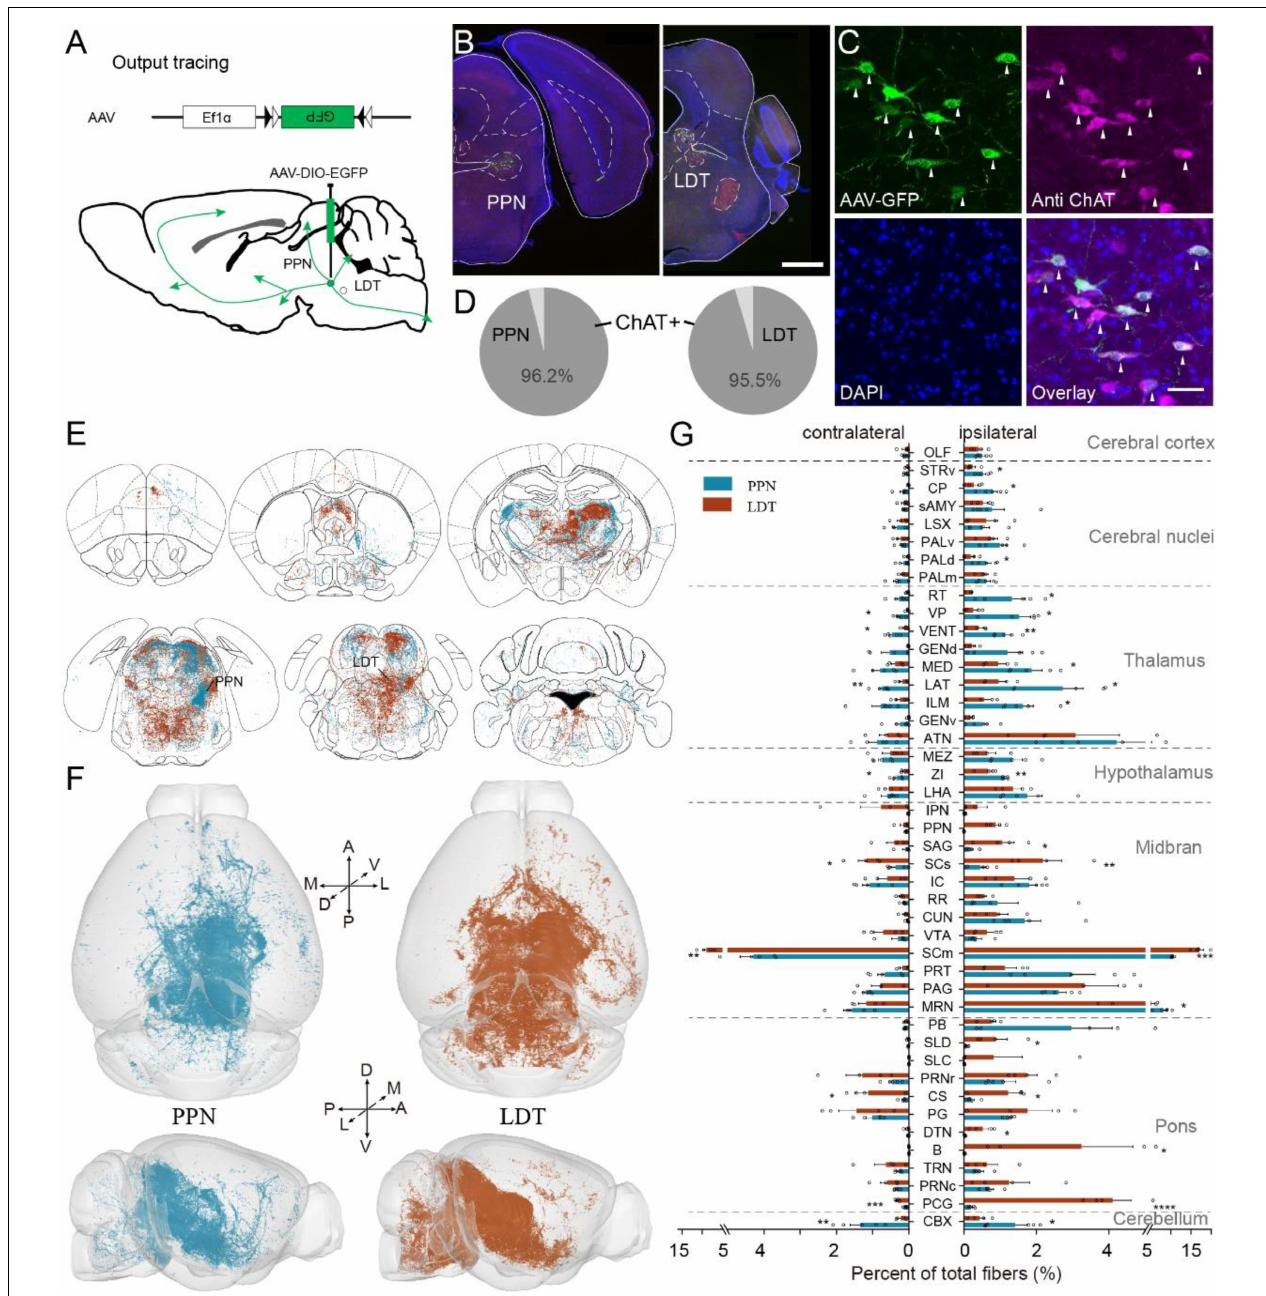
FIGURE 3 | Whole brain projection of PMT cholinergic neurons. (A) The methods and processes for output tracing. (B) A typical coronal plane of an inject site; labeled cholinergic neurons are limited in object regions. (C) Immunofluorescent staining of cholinergic neurons; arrows point out ChAT-positive neurons. (D) The proportion of ChAT-positive neurons, PPN, 3 mice; LDT, 3 mice. (E) The whole-brain projection of PMT cholinergic neurons. (F) The 3D view of cholinergic projections in the whole brain. Left figures display the whole-brain projection of the PPN; right represents LDT. (G) Quantitative statistical proportion of main targeting regions from PPN and LDT. The left side of vertical axis represents proportion of cholinergic fibers in the contralateral hemispheres, while the right side represents ipsilateral hemispheres. A scale bar, (B) 1,000 µ m; (C) 50 µ m. The abbreviations of brain regions are provided in Supplementary Table 1 . Data are shown as mean ± SEM. Two-sided t -tests, * p < 0.05, ** p < 0.01, *** p < 0.001, **** p < 0.0001; PPN, 5 mice; LDT, 4 mice. For detailed P values, see Supplementary Table 2